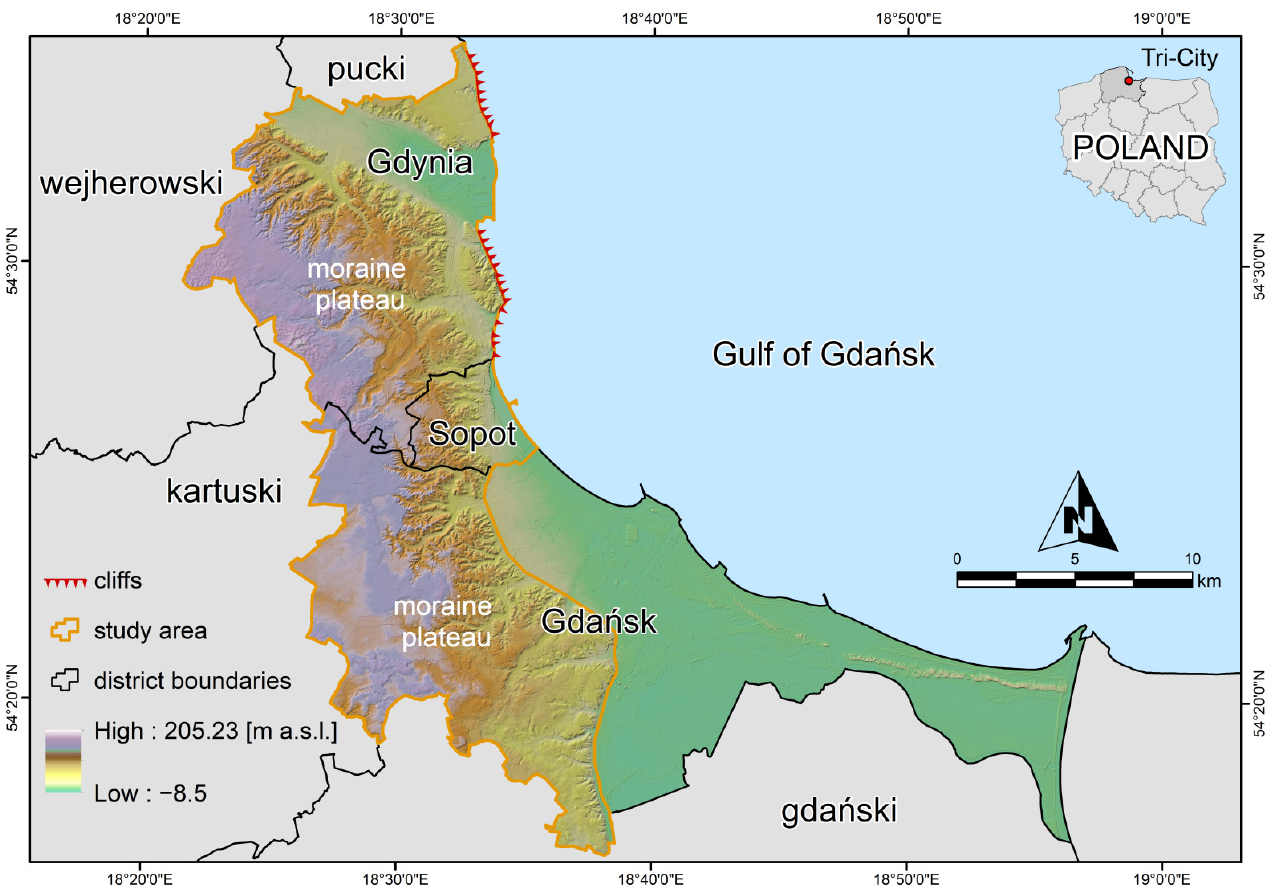
Figure 1. Location of the study area. District boundaries are administrative boundaries. District is the second-level unit of local government and administration in Poland.